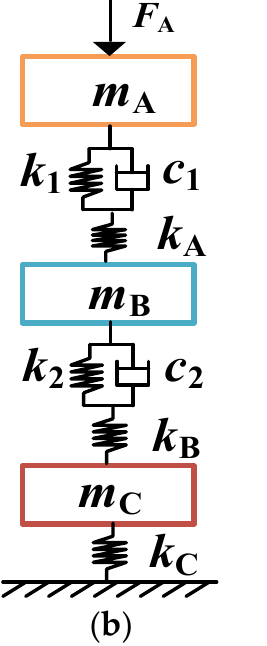
Figure 5. Dynamic models of the AUG with ( a ) the single-stage vibration isolator and ( b ) the two- stage vibration isolator.